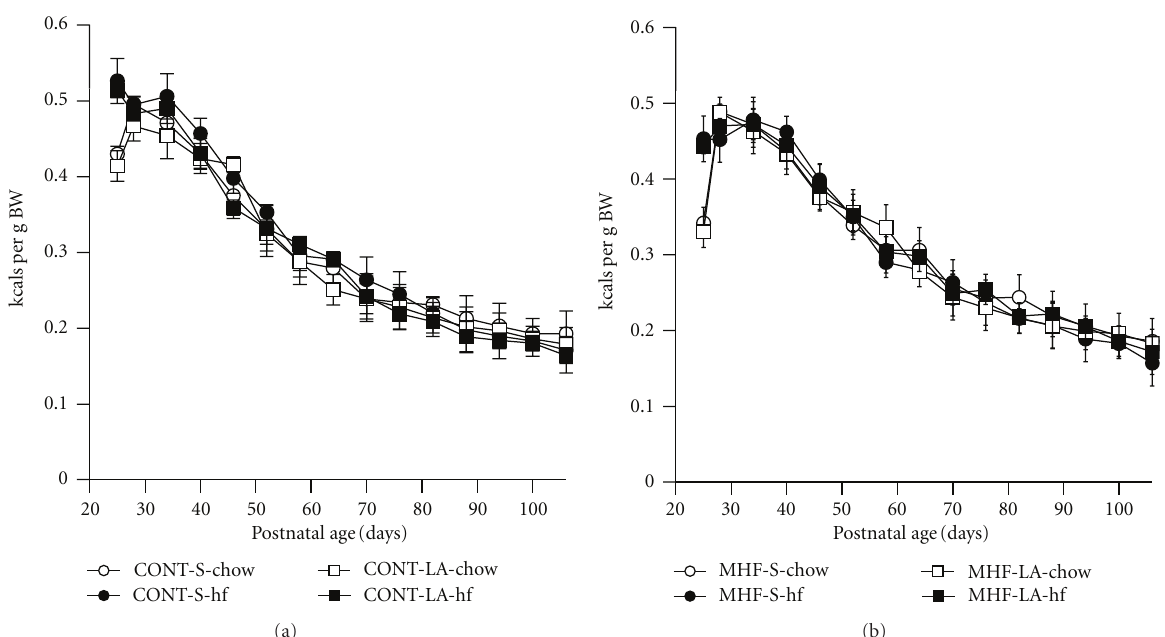
Figure 5: Total caloric intake (kcals consumed per gram body weight) in male o ff spring of CON mothers (a) or MHF mothers (b) from birth until the completion of the trial. Data are average caloric intakes per cage of 2 animals, minimum of 4 cages per group.